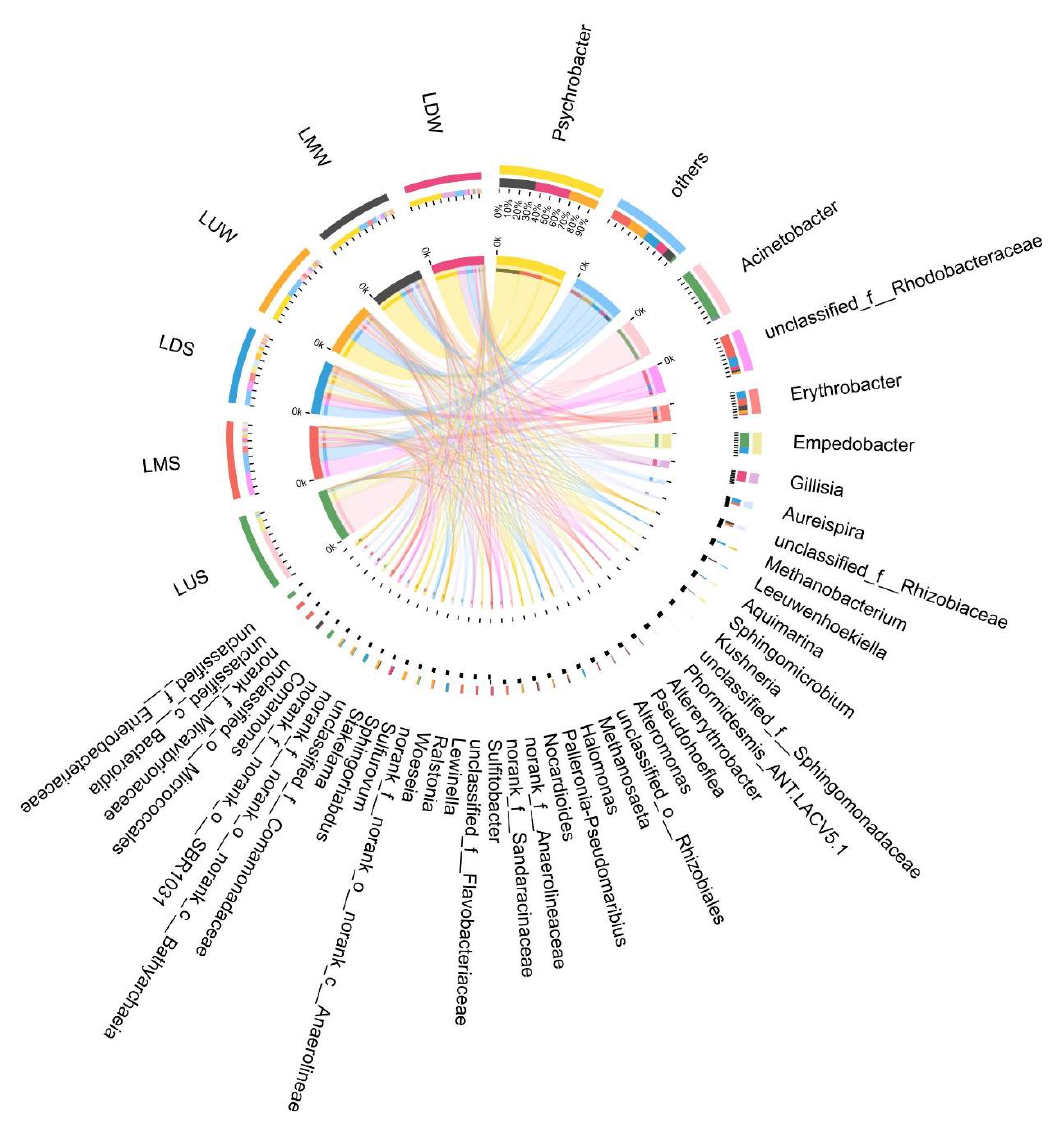
Figure 4. Circos map was used to describe the relationship between samples and species at the ge- nus level. LUS: summer samples of upper leaves; LMS: summer samples of middle leaves; LDS: summer samples of lower leaves; LUW: winter samples of upper leaves; LMW: winter samples of middle leaves; LDW: winter samples of lower leaves.